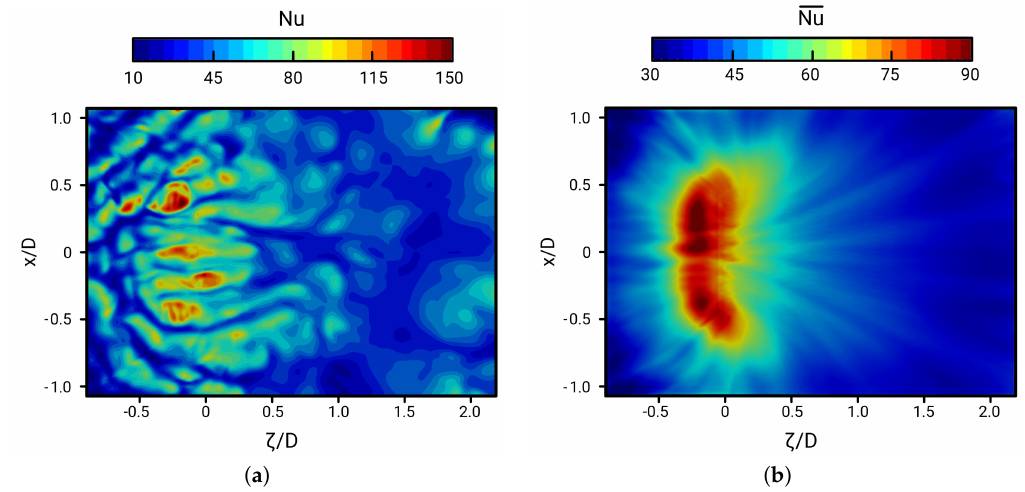
Figure 8. ( a ) Instantaneous and ( b ) time-averaged instances of the Nusselt number at the impinging wall. To complete the DNS database of near-wall thermal statistics, profiles of time-averaged Nu numbers are provided in Figure 9a,b in the span-wise and wall-parallel direction, respectively. Supplementary profiles of the wall shear stress are included to highlight the correlation of heat and fluid flow in the vicinity of the wall. Both datasets might be of particular interest for validation purpose for near-wall modeling strategies of heat and fluid flow in the context of both LES and RANS.